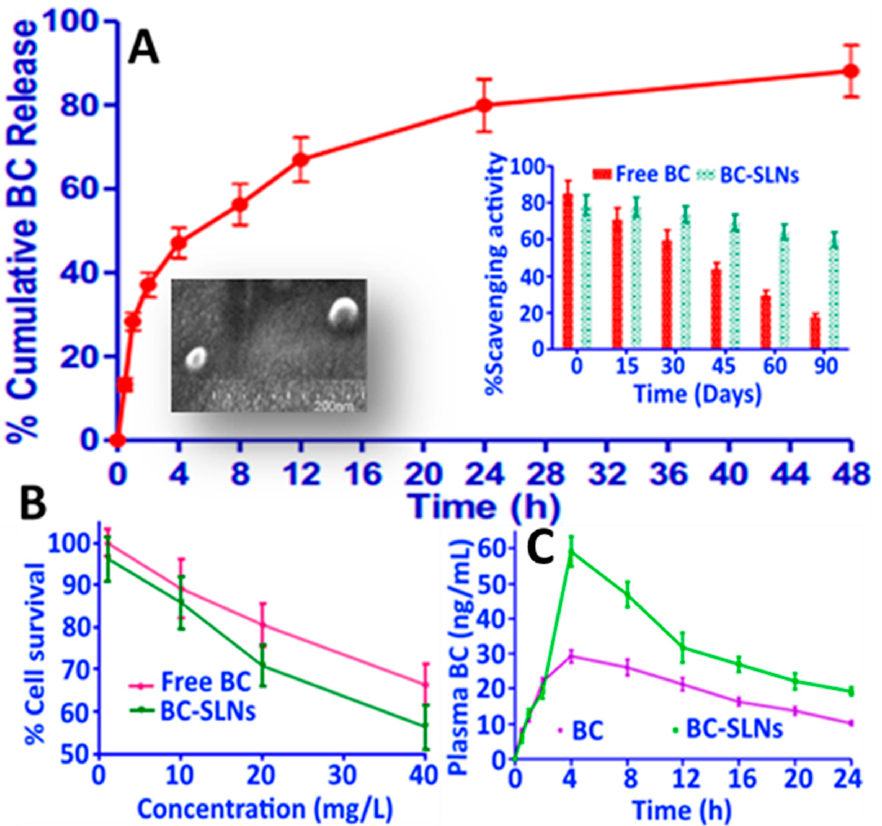
Figure 11. In vitro release profile of β -carotene from β -carotene solid lipid nanoparticles in 0.1 N hydrochloric acid along with two insets showing the scanning electron microscopic image of β - carotene solid lipid nanoparticles and antioxidant activity of free β -carotene and β -carotene solid lipid nanoparticles ( A ) as well as their anti-breast cancer activity towards MCF-7 cells after 48 h of incubation ( B ) and plasma β -carotene levels as a function of time after administering in mice ( C ). The results were expressed as mean ± standard deviation of ≥ 3 independent replicates and error bars represent the standard deviation from mean values. BC = β -carotene and SLNs = solid lipid nanoparticles. Adapted with permission from Jain, et al. [56]. To increase the stability and antioxidant activity of carotenoids crocin and crocetin, Puglia, et al. [110] prepared SLNPs-based nanocarriers using quasi-emulsion solvent and solvent diffusion methods, respectively. Both crocin- and crocetin-SLNPs showed high stability and homogeneity with a mean particle size at 273.3 and 278.1 nm, polydispersity index at 0.16 and 0.31, ZP at 30.2 and 17.8 mV and EE at 82.1 and 94.0%, respectively. Based on the oxygen radical absorbance capacity assay, a higher antioxidant activity in terms of relative fluorescence units (RFU) was obtained for crocin-SLNPs (1000–35,000 RFU) and crocetin-SLNPs (2500–38,000 RFU) compared to unloaded SLNPs (Figure 12A). Also, an in vitro release of 68 and 60% using gastric fluids was shown for crocin-SLNPs and crocetin- SLNPs, respectively (Figure 12B), while both could inhibit growth of human melanoma cancer cell A375 (Figure 12C) and malignant Schwann cell sNF96.2 (Figure